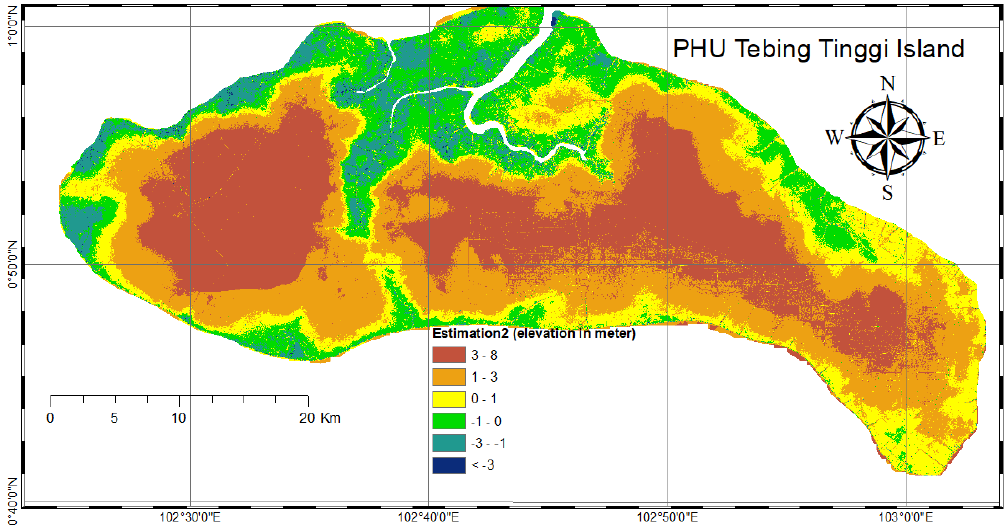
Figure 5. Mineral soil position of estimation results by ignoring gravity parameters and outliers. Note: the elevation is above the local MSL.